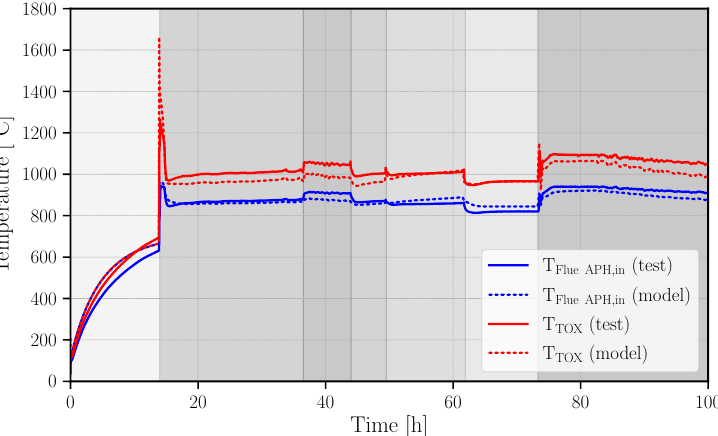
Figure 14. Modeled and measured temperatures of the hotbox, TOX and flue gas inlet at the air pre-heater (APH) during start-up and load changes from 1000, 1150, 1000, 800, 600 and 1150 W el . The temperatures can be modeled with a low deviation of less than 4% for all load points, except for the TOX temperature, which shows a deviation up to 6% during higher load points. Interestingly, the deviation at the POX inlet from the OPH is higher for